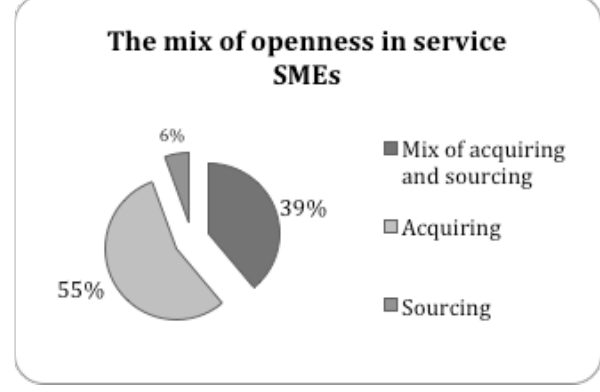
Fig. 1. The mix of openness in service